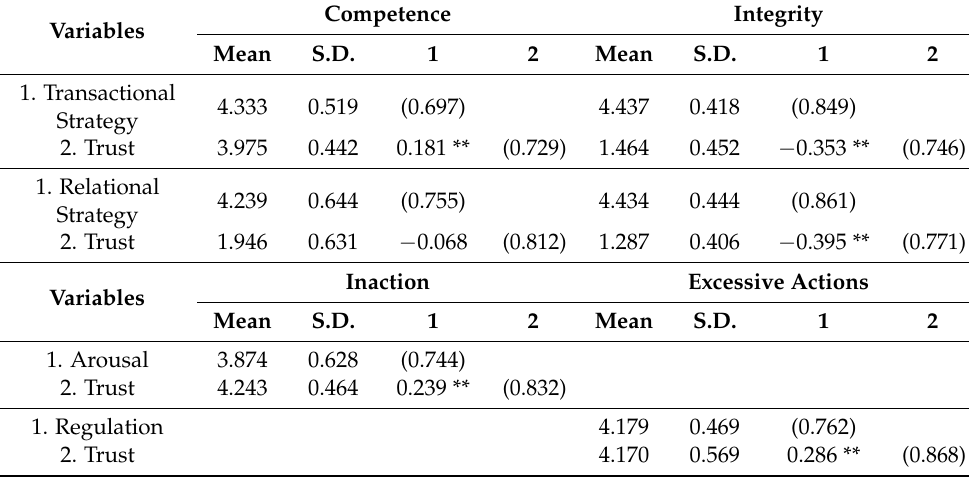
Table 3. Construct correlations and comparison with the square root of